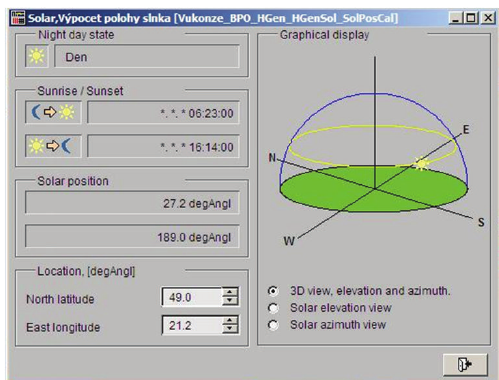
Figure 11: Parameters setting on the screen of the calculation of the Sun position.